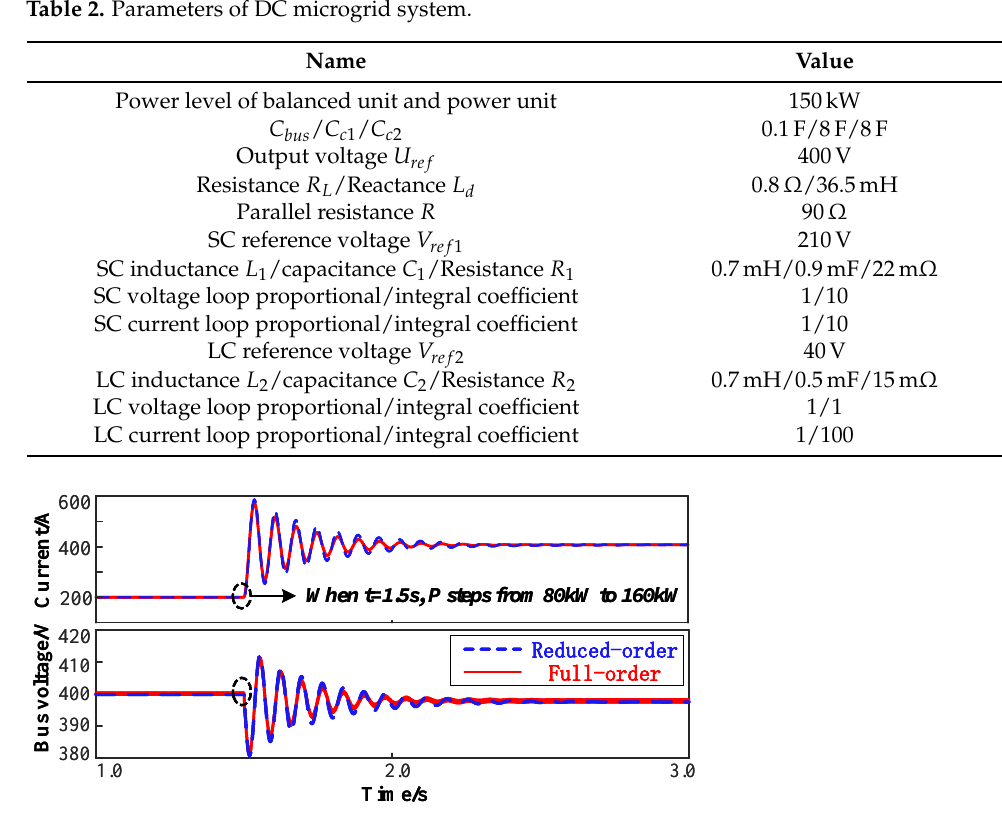
Figure 6. Time-domain simulationcomparison between reduced-order model and full-order